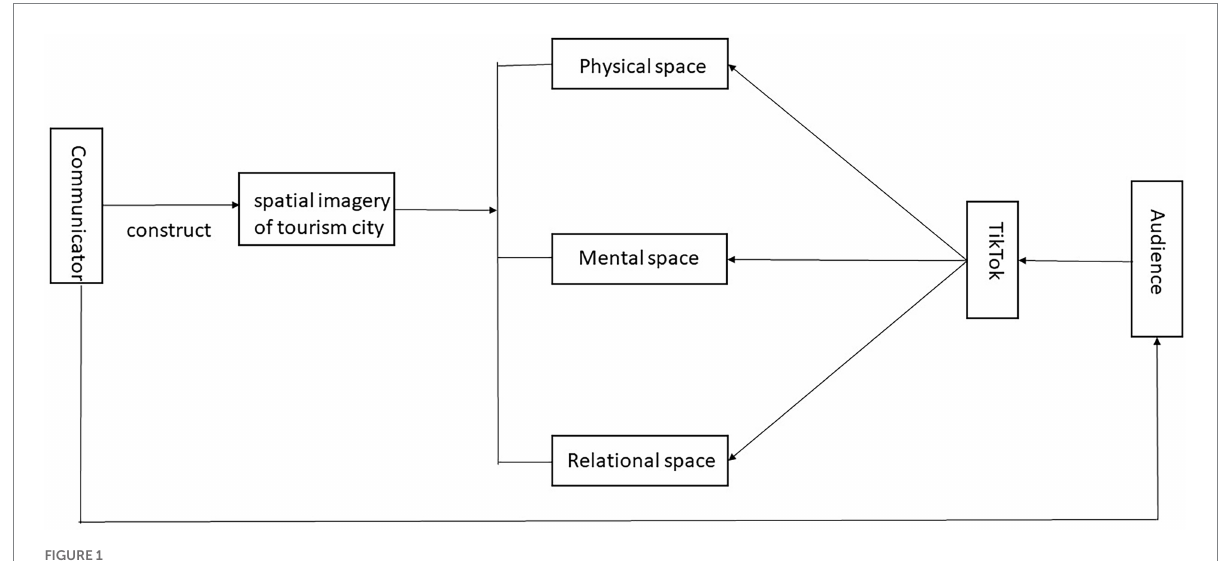
FIGURE 1 The physical, mental, and relational imagery of a tourism